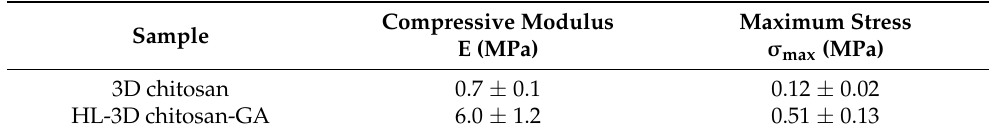
Table 4. Compressive modulus E and maximum stress ( σ max ) at a strain level of 0.3 mm/mm for 3D chitosan and HL-3D chitosan-GA complex.